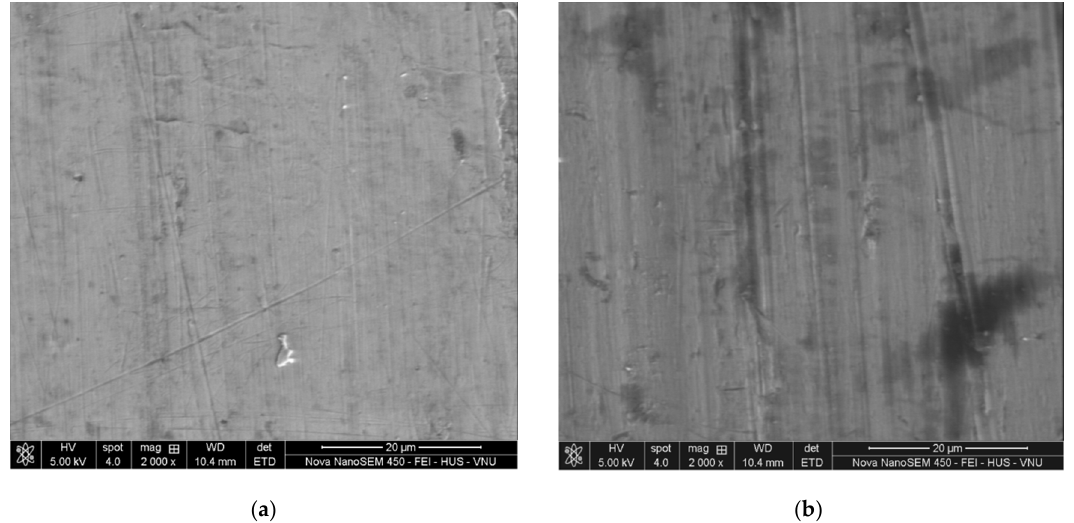
Figure 9. SEM images at various conditions: ( a ) SEM images at experimental No. 13, and ( b ) SEM images at experimental No. 17.